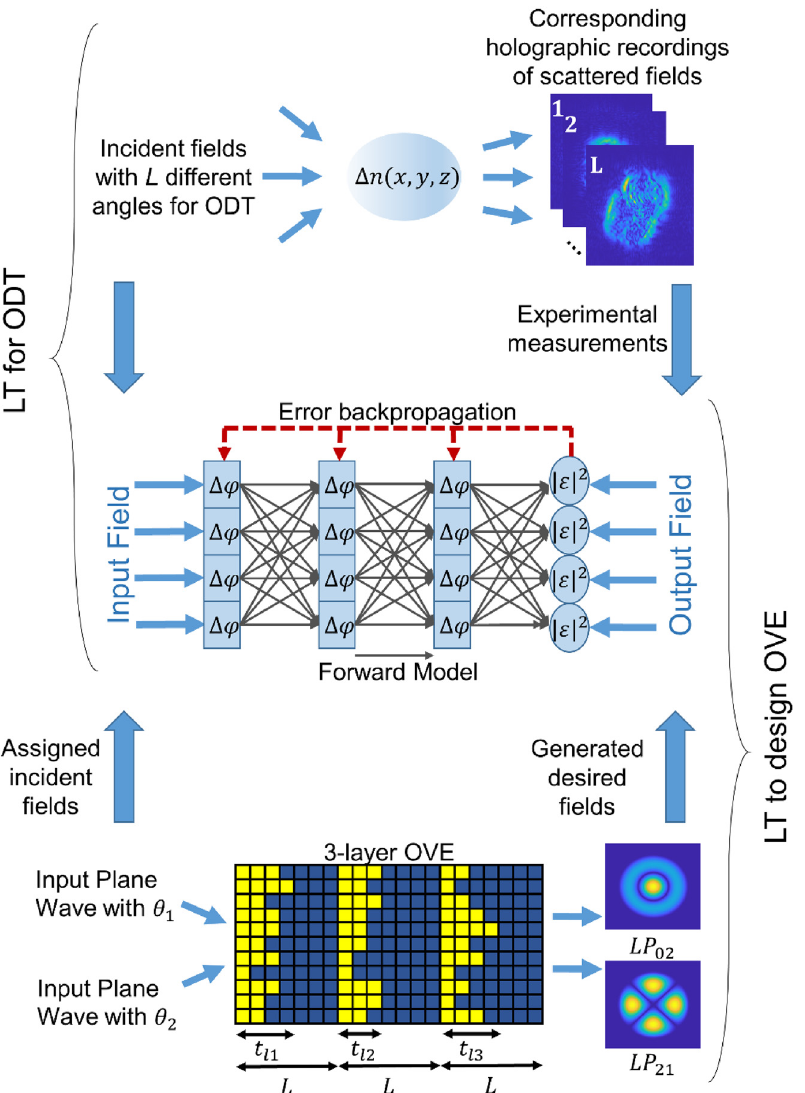
Figure 1: Optimization scheme of LT utilized in ODT and design of OVEs. Δ φ is the phase modulation of a voxel and | ε | 2 is the mean squared error between the reconstructed fi eld of the computational model and the desiredoutput fi eld.Eventhoughthevoxels are drawn separated to make room to indicate the forward model, they are physically adjacent. A representative sketchof a 3-layer computergeneratedOVE is shown in the bottom part. t l 1 , t l 2 , t l 3 are layer thicknesses and L is the layer separation. For LP 02 and LP 21 , the amplitude maps are